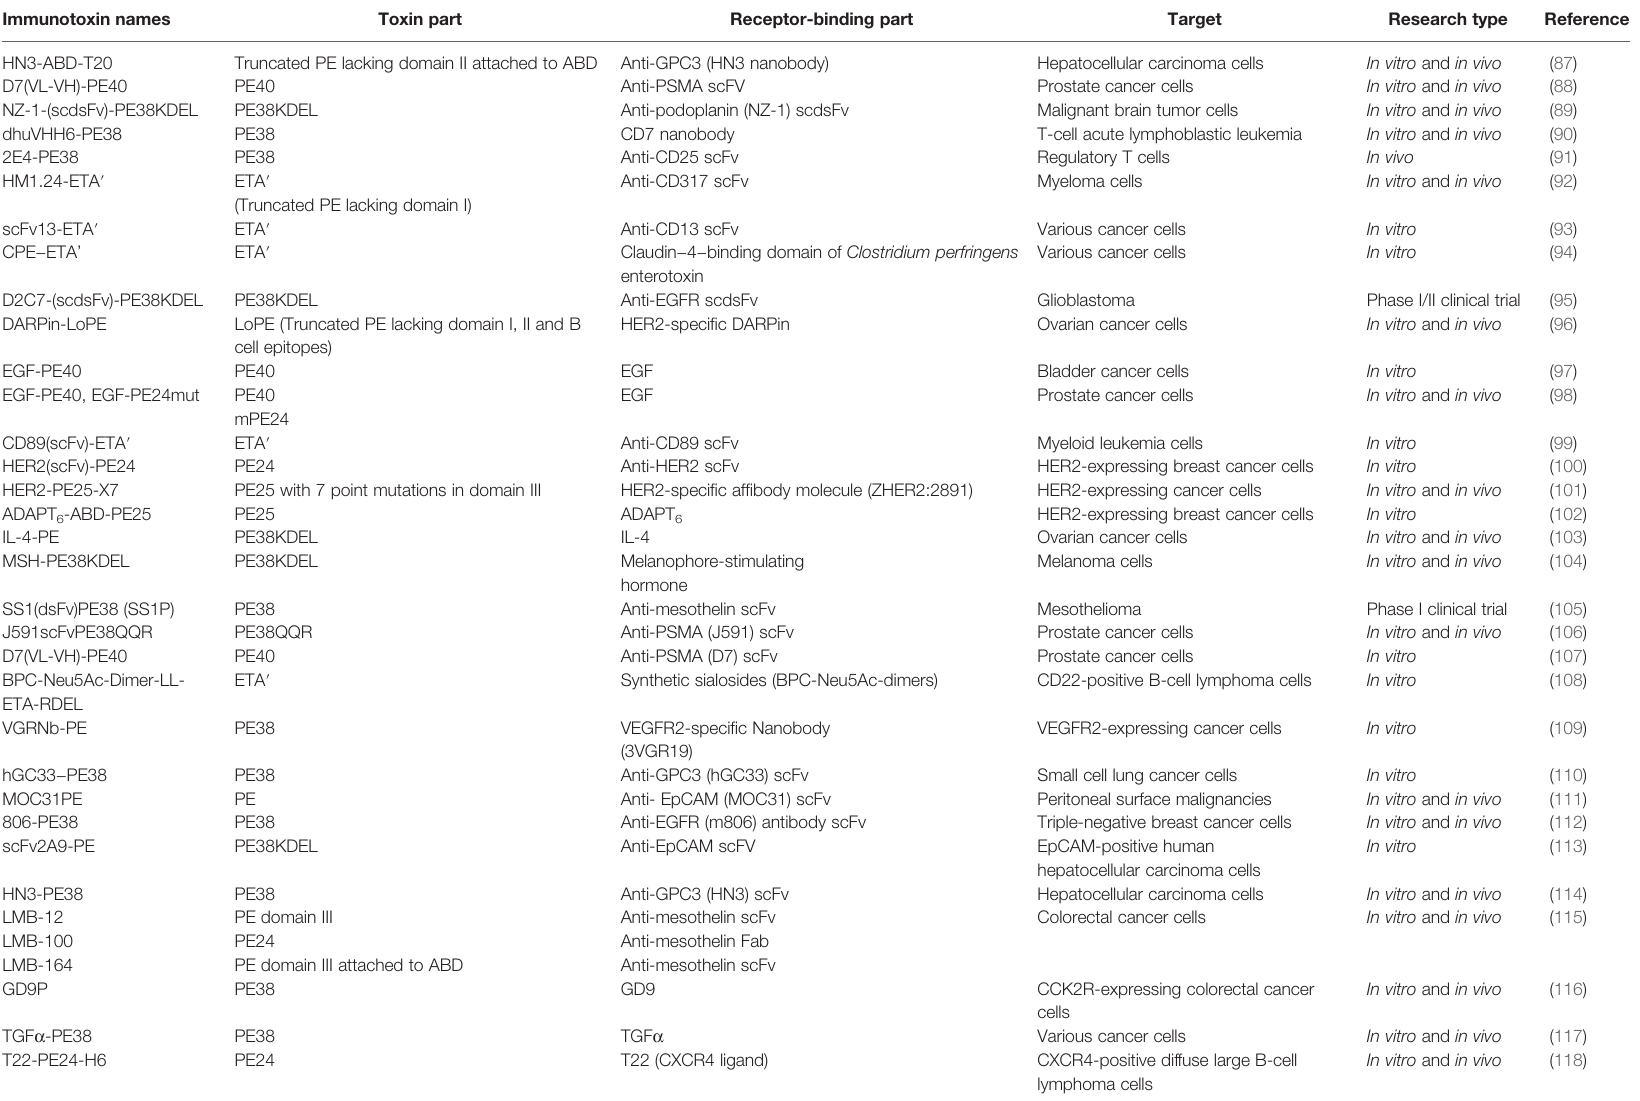
TABLE 1 | A summary of PE-based immunotoxins discovered and evaluated in the past decade for cancer